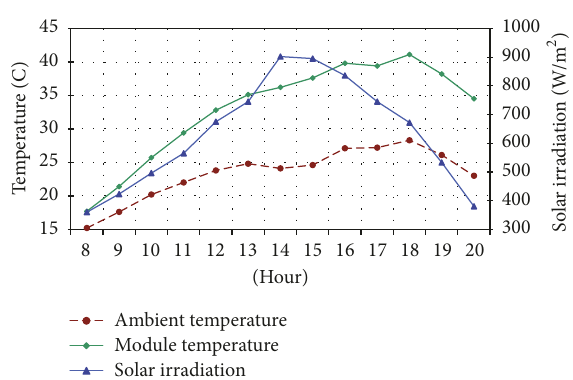
Figure 18: The 𝑇 - 𝑡 - 𝐺 experimental characteristics for PFV ALTIUS 235W.